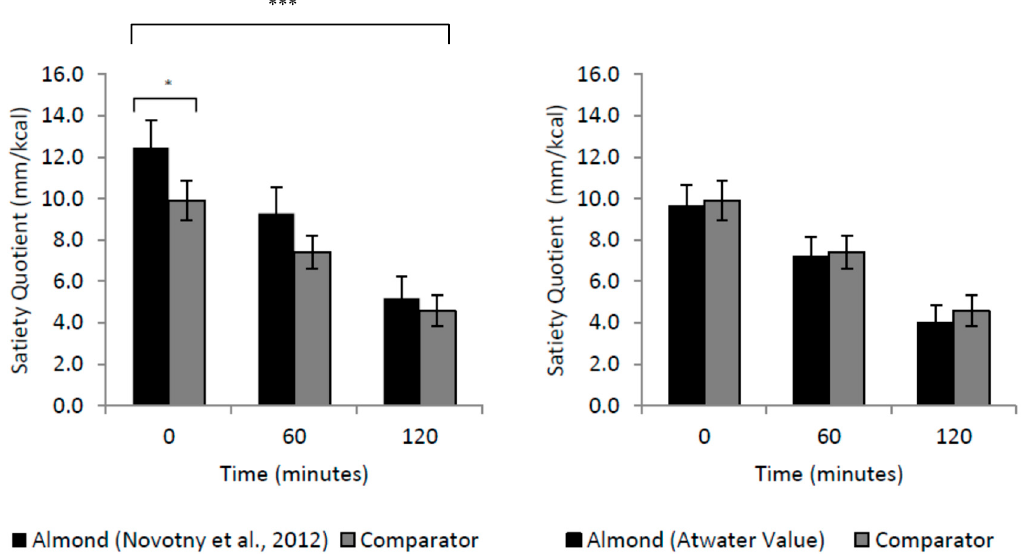
Figure 4. Satiating efficiency of the snacks, 120 minutes post consumption. * p < 0.05; *** p < 0.001.